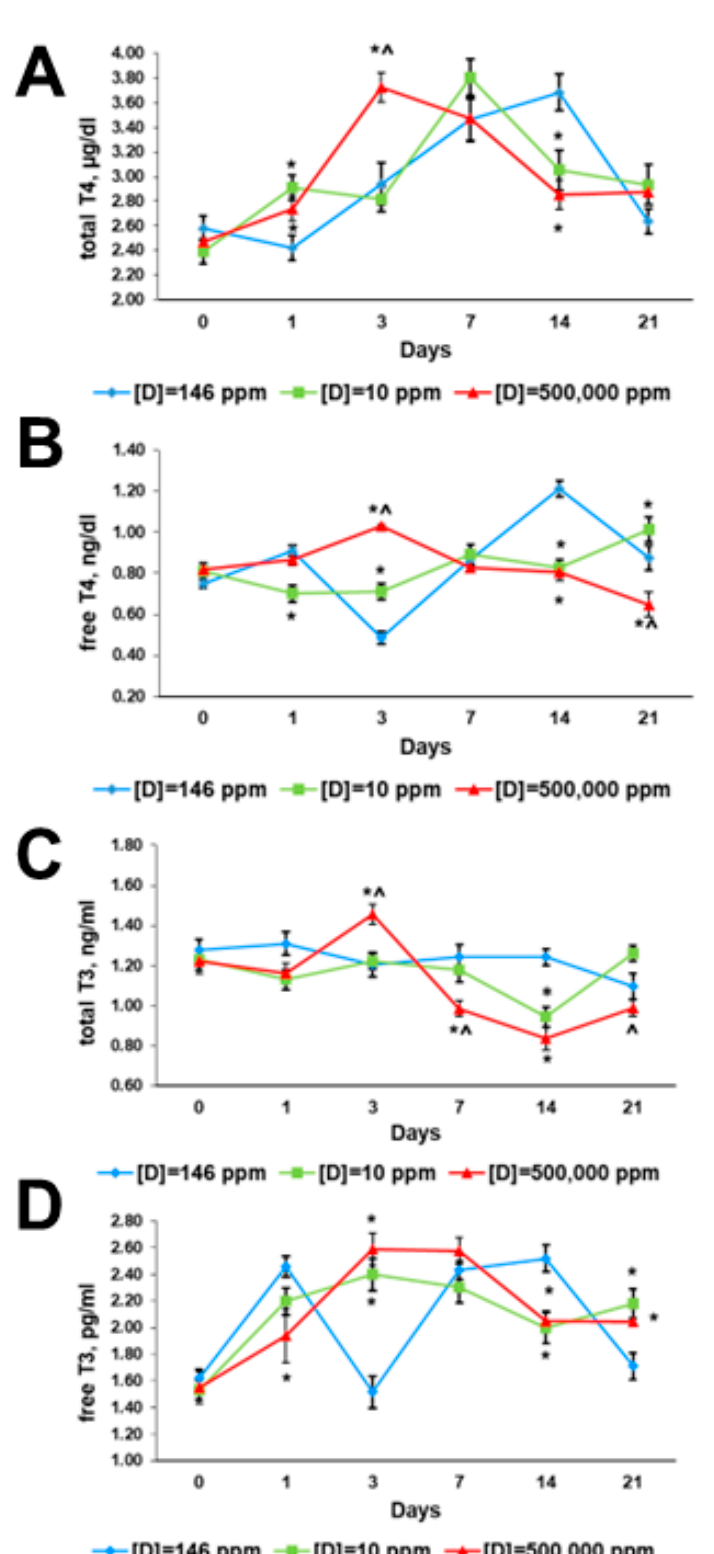
Figure 3. Thyroid hormone profiles of the rats that consumed water with modified deuterium content for 21 days. ( A ) Total T4 serum concentrations; ( B ) free T4 serum concentrations; ( C ) total T3 serum concentrations; ( D ) free T3 serum concentrations. Data are shown as mean ± S.E.M.; p < 0.05 compared to the control (*) and to the rats that consumed water with [D] = 10 ppm (^).